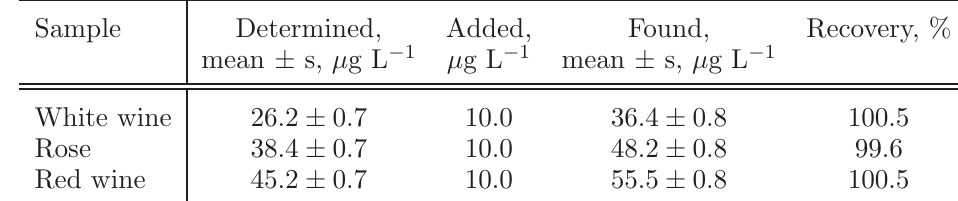
Table 4 Added/found method for Pb determination in wine by Varian, SpectrAA 880 deuterium arc, n = 5; t = 2 . (0 . 95;4)